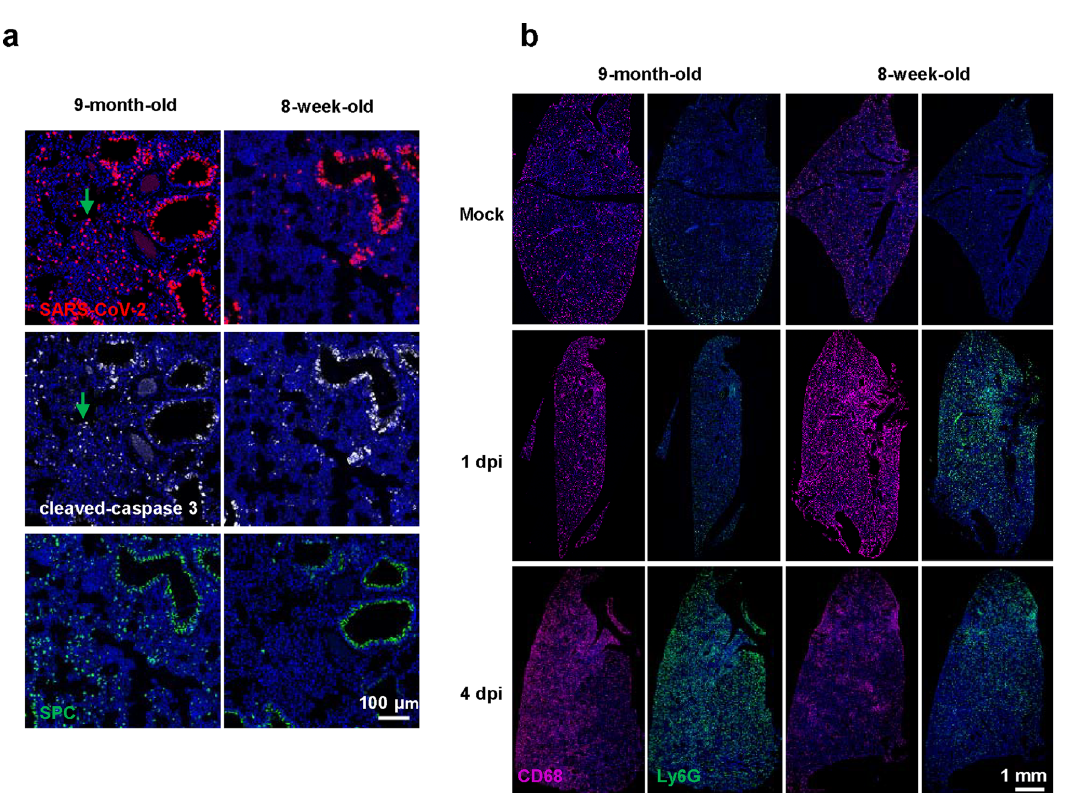
Fig. 6 Lung-speci fi c response of 8-week-old and 9-month-old male BALB/c mice during MASCp36 infection. a Multiplex immuno fl uorescence staining for detection of SARS-CoV-2 N protein (red), Cleaved caspase-3 (white), and SPC (green) expression in lung tissues of male mice (9-month-old and 8- week-old) at 1 dpi. The green arrows indicate apoptotic cells with MASCp36 infection in the alveolar region ( n = 3 per group) b Multiplex immuno fl uorescence staining for CD68 + macrophages and Ly-6G + neutrophils in fi ltration in 9-month-old mice and 8-week-old mice after infection at 1 and 4 dpi. Less CD68 + macrophages and Ly-6G + neutrophils were detected in 9-month-old mice than that in young mice 1 dpi, and reversed on 4 dpi ( n = 3 per